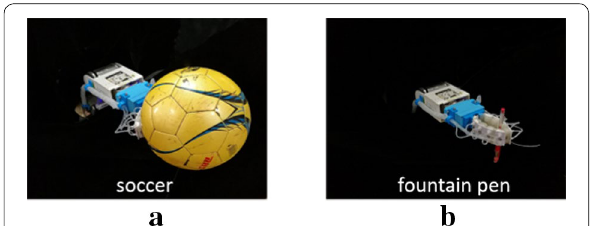
Figure 3 Grasp soccer and fountain